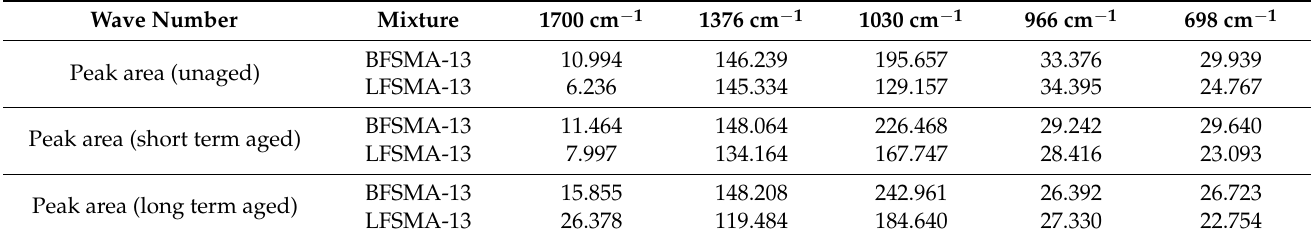
Table 8. Characteristic peak areas of SBS modified extracted from